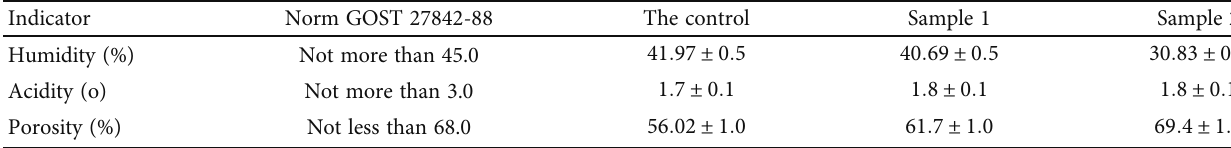
Table 3: Physical and chemical properties of prototypes of bread.